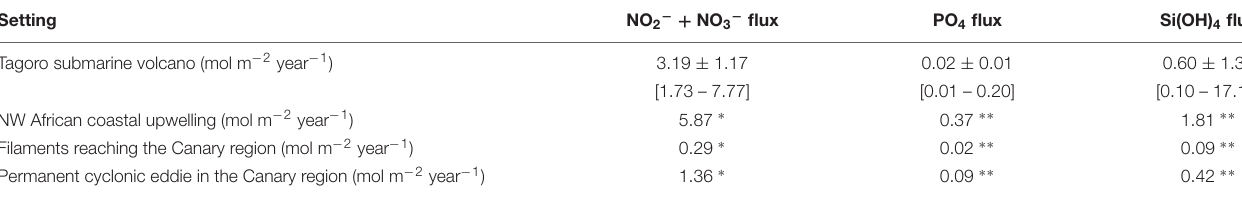
TABLE 2 | Nutrient fluxes calculated from a transect perpendicular to the main current during the degassing stage.